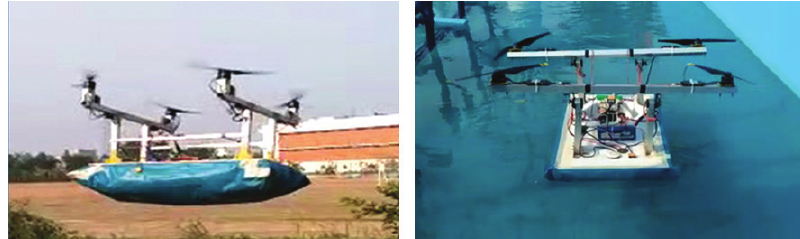
Figure 10. An experimental test of UAAV in aerial mode and hovering in the